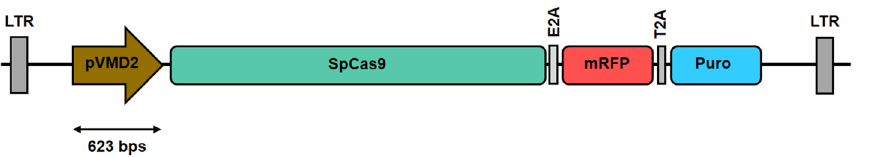
Figure 1. The schematic construct of the pVMD2-SpCas9-E2A-mRFP-T2A-Puro vector. The CMV promoter was substituted with the human VMD2 promoter (623 bps long) which is located at − 585 to + 38 bp of human